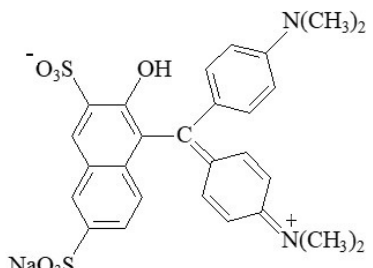
Figure 26. Structural formula of green S (E142).